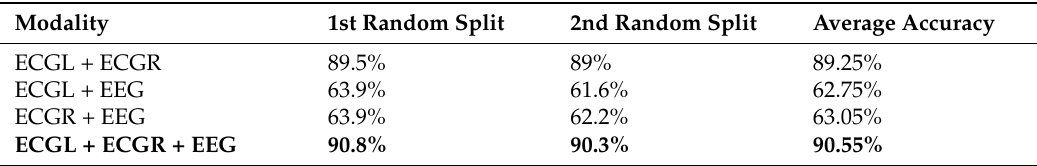
Table 6. DREAMER results for majority voting. Highlighted row represents best-performing combination of